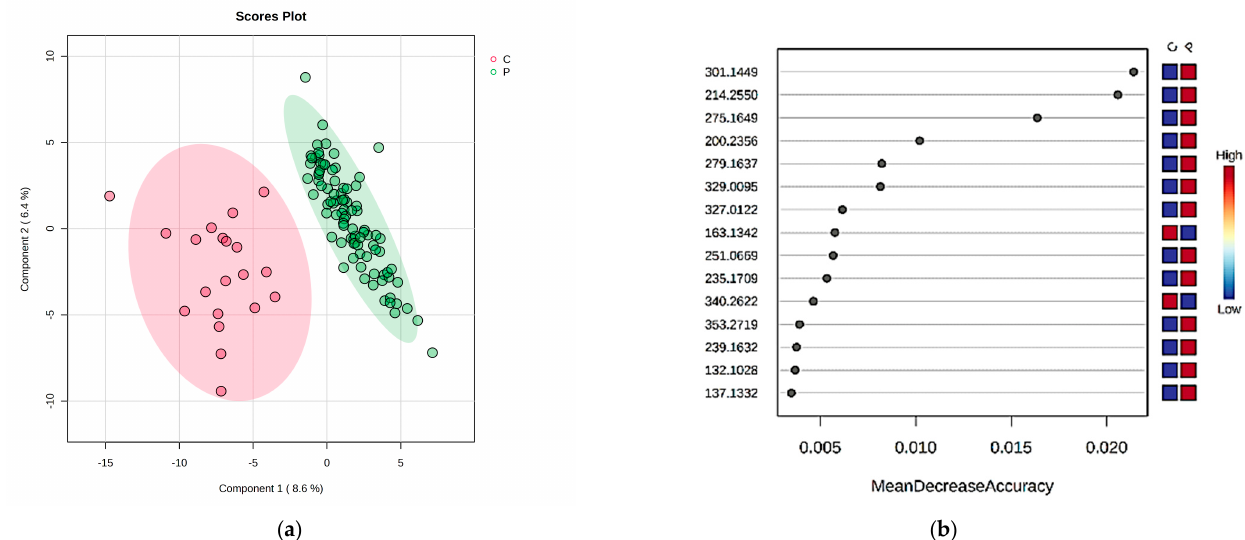
Figure 2. Multivariate analysis of urine samples; ( a ) PLSDA score and plot for urine samples; ( b ) Random Forest: MDA score for urine samples .